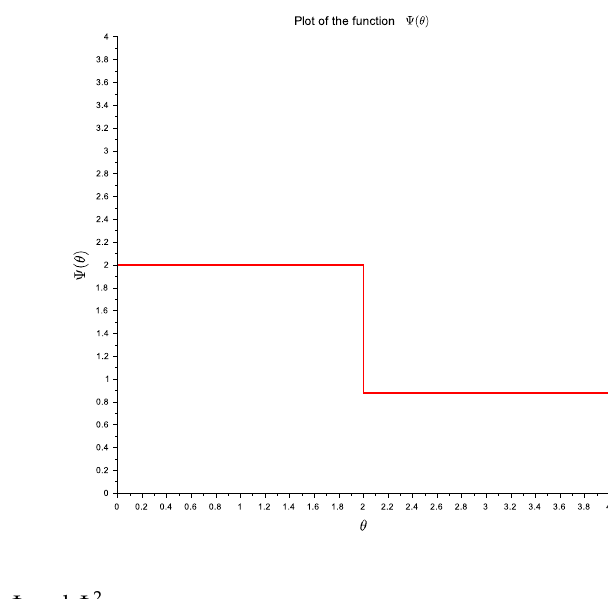
Figure 1. Plot of the functions Φ and Φ 2